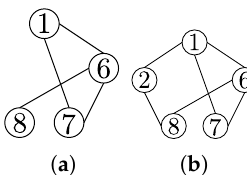
Figure 7. Transitions between successive shunt converter vectors in a voltage zone. ( a ) Example for zone z 1 . ( b ) Example for zone z 2